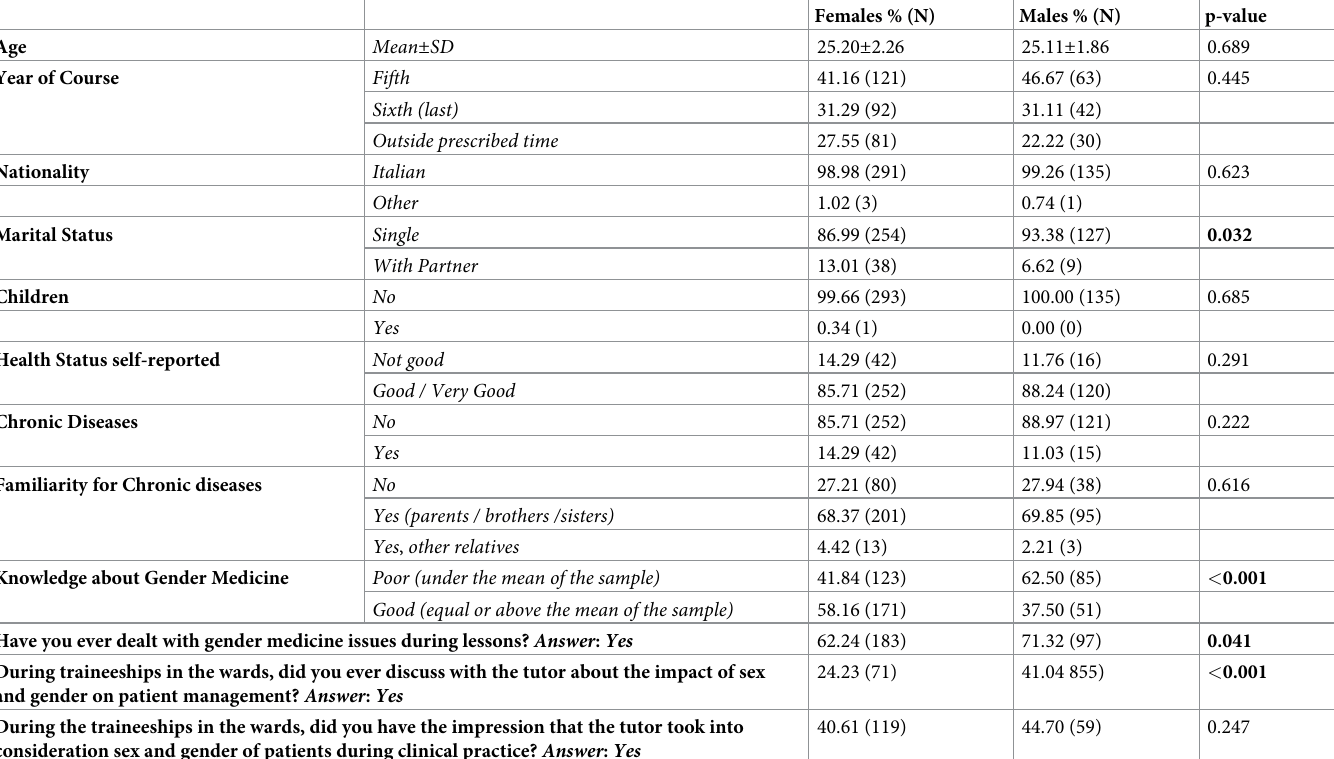
Table 1. Description of the sample (N =